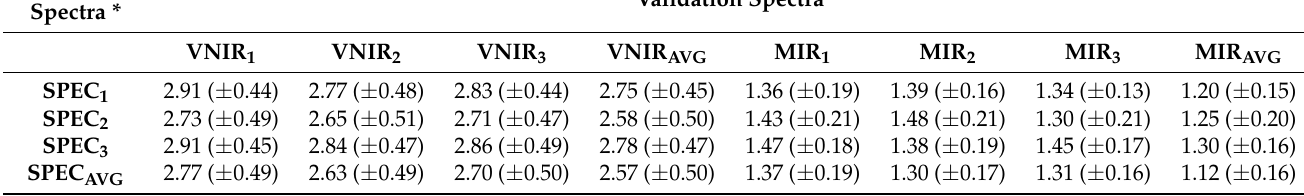
Table 6. Validation accuracy (RMSE in g · kg − 1 ) of VNIR and MIR SOC models for different combina- tions of calibration and validation (prediction) spectra using the laboratory-average SOC (Lab AVG ) as reference data. Statistics represent average RMSE values of 100 randomized runs of the nested cross-validation approach with two standard deviations of their respective distributions given in